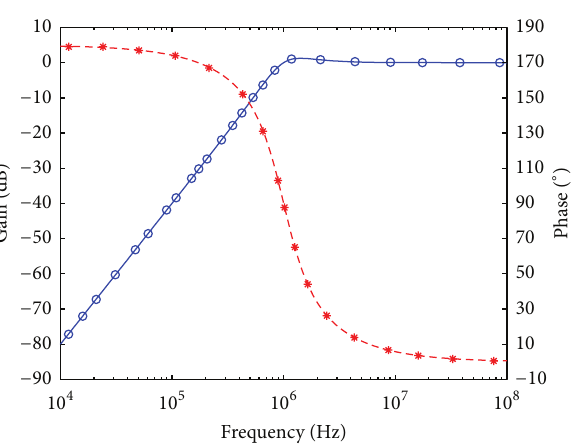
Figure 10: Simulated gain-frequency and phase-frequency respons- es of noninverting high-pass filter at 𝑉 𝑜4 ( ∘ : simulated gain; ∗ : simulated phase; — and ---: theoretical curves).